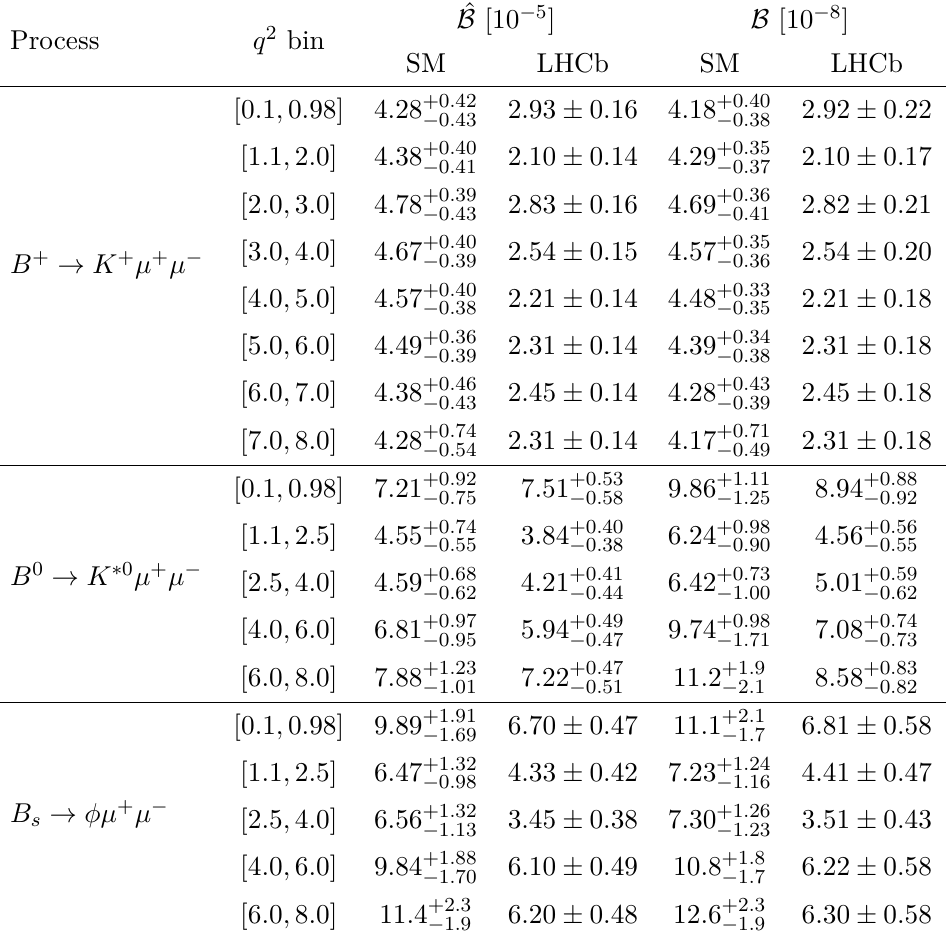
Table 13 . SM predictions and measurements by the LHCb experiment [73, 81, 83] for the integrated branching ratios B and the integrated normalized branching ratios ˆ B ≡ B ( B → Mµ + µ − ) / B ( B → MJ/ψ ) . Our predictions for the integrated B account for correlations between the normalized pre- dictions and the normalization channel. Ignoring tiny differences due to the masses, the predictions for the modes B 0 → K 0 µ + µ − and B + → K ∗ + µ + µ − can be obtained by rescaling with the ratio of B lifetimes. Note that we provide the central 68% intervals and that the posterior-predictive distributions are not